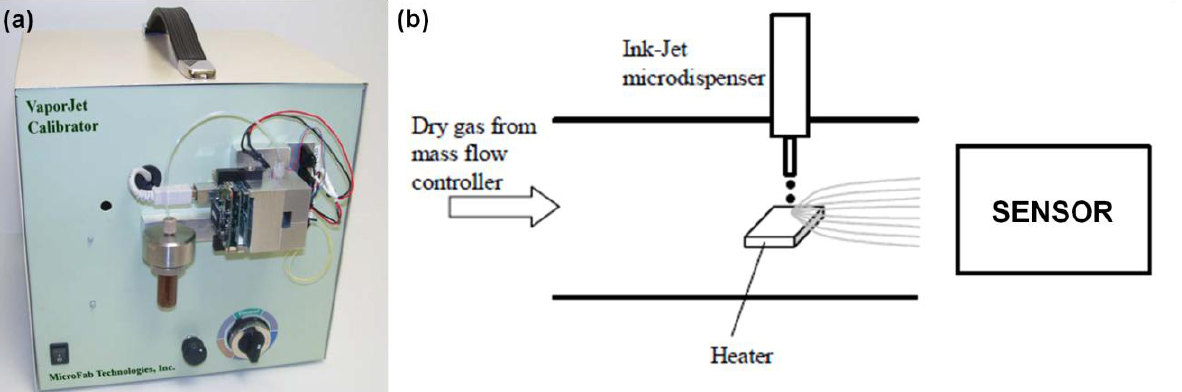
Figure 2. VaporJet calibrator ( a ) and principle of operation ( b